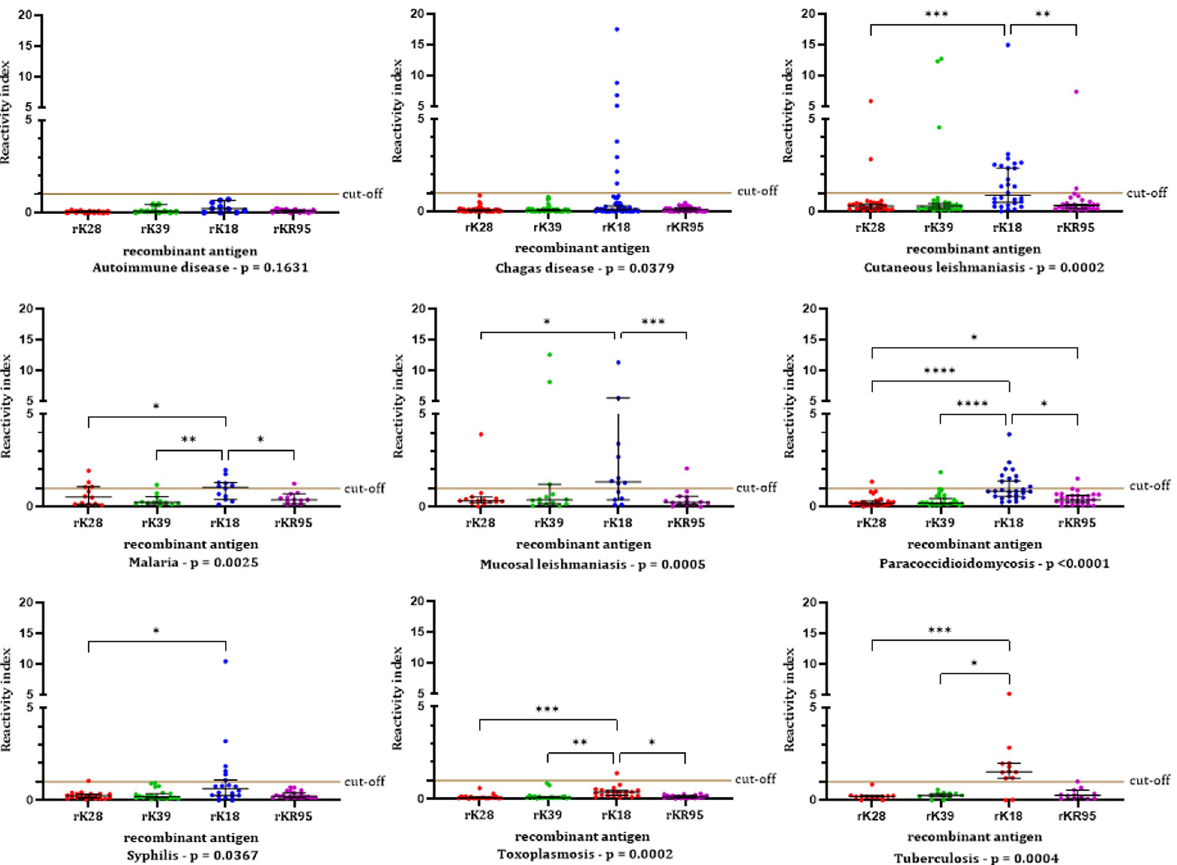
Fig 6. Antigen-specific antibodies in sera patients with potentially confounding infectious diseases (Panel 3) developed for recombinant antigens. The horizontal black lines represent the median ABS% Positive Control values with a 95% confidence interval. Friedman test (p values are in the graphic for each disease), followed by Dunn’s multiple comparisons test: Cutaneous leishmaniasis: �� —p = 0.0038; ��� —p = 0.0002. Malaria: � —p = 0.0342 (rK28 x rK18) and p = 0.0170 (rK18 x rKR95); �� —p = 0.0011. Mucosal leishmaniasis: � —p = 0.0325; ��� —p = 0.0002. Paracoccidioidomycosis: � —p = 0.0225 (r18 x rKR95) and p = 0.0368 (rK28 x rKR95); ���� —p < 0.0001. Syphilis: � —p = 0.0291. Toxoplasmosis: � — p = 0.0351; �� —p = 0.0057; ��� —p = 0.0001. Tuberculosis: � —p = 0.0207; ��� —p = 0.0003.